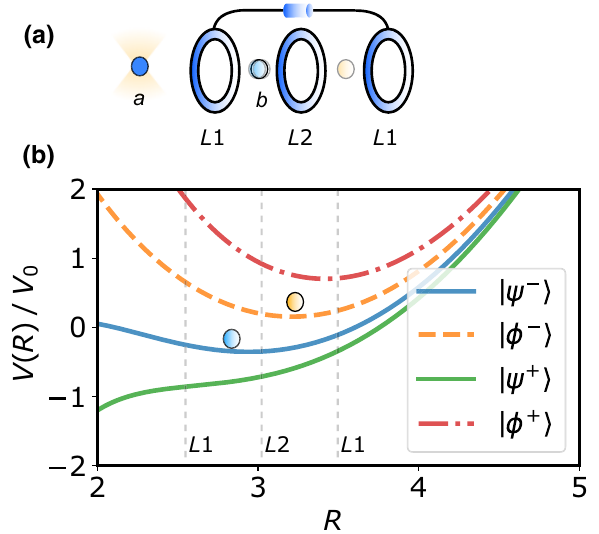
FIG. 1. (a) The schematics for a conceptual qubot model capa- ble of partially protecting an arbitrary logical qubit state against decoherence. (b) An example of a possible potential landscape describing the interaction between the nucleus atoms; for this plot, the radial dependence of Eq. (2) is considered: J α ( R ) = = − 3 j = 6 j ( d 2 / R 3 ) j α , with j y x , j z x